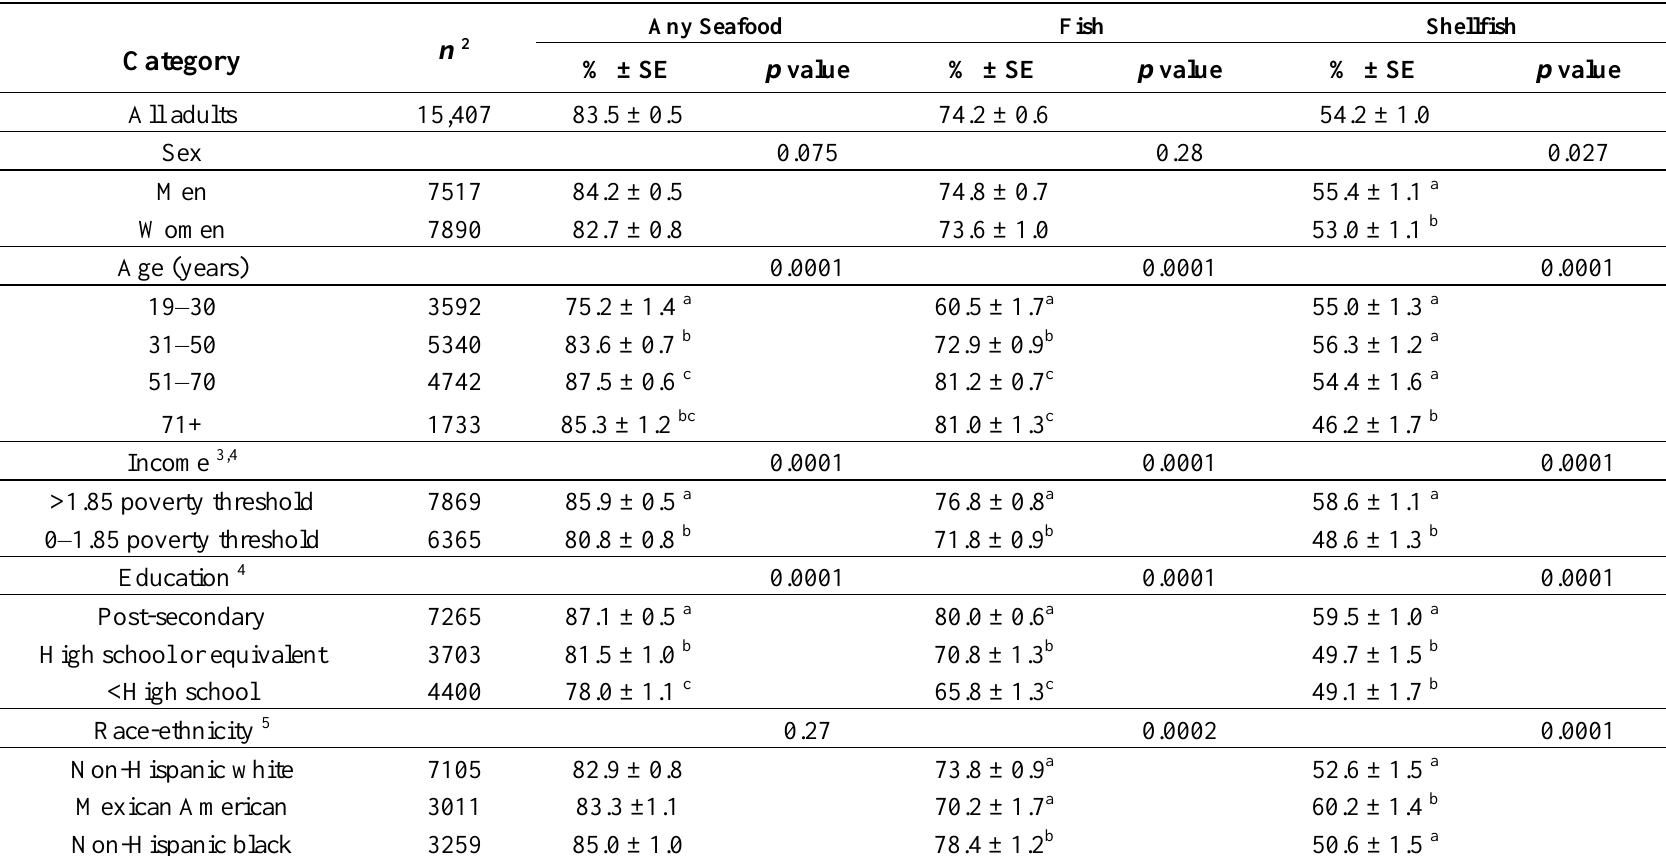
Table 1. Percentage of adults aged ≥ 19 years who report eating seafood in the past 30 days 1